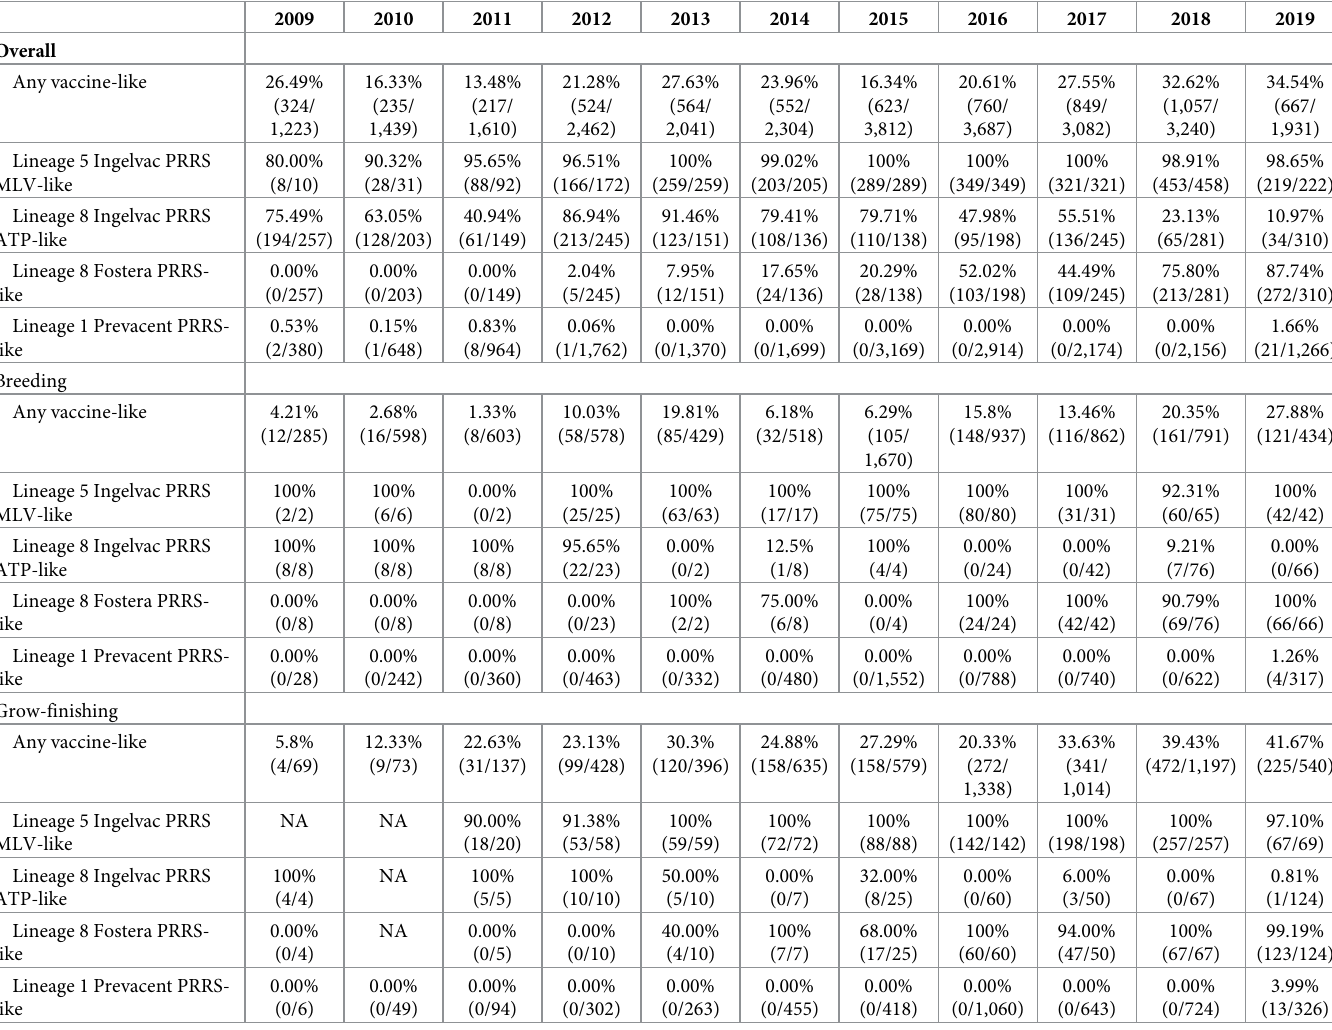
Table 3. Frequency of PRRSV-2 sequences similar to vaccine strains at a > 5% nucleotide identity cutoff overall and by herd type between 2009 and 2019 in the